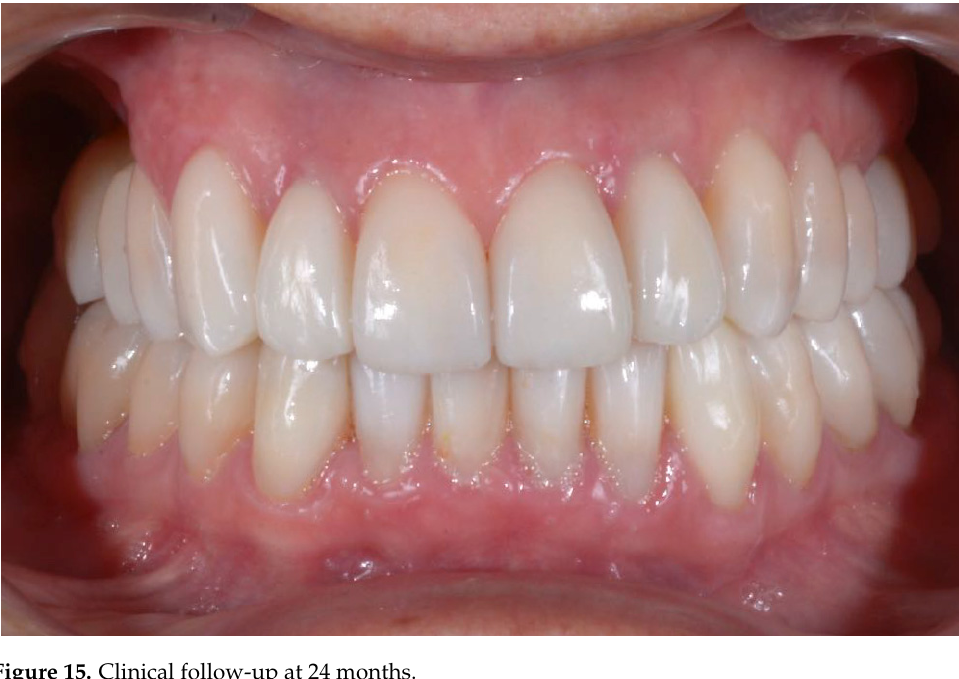
Figure 15. Clinical follow-up at 24 months.